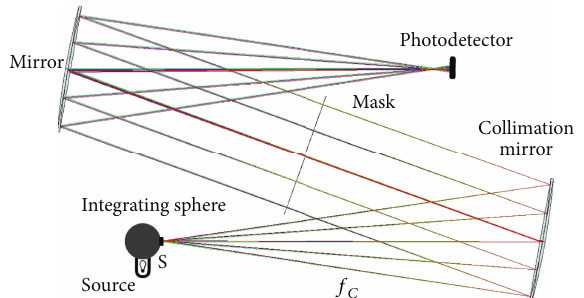
Figure 4: Scheme of set-up L2 (for entering light measurement on large